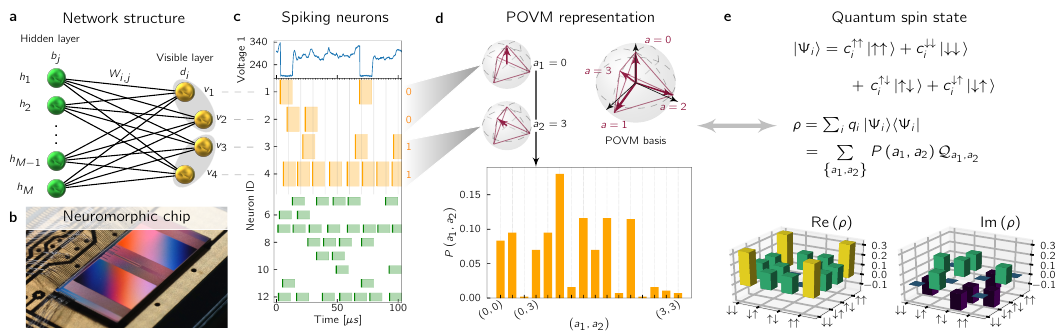
Figure 1: Neuromorphic representation of quantum states. a , Two-layer spiking network architecture with weight parameters W between the visible (orange) and i , j hidden (green) neurons and biases d ( b ) for the binary visible (hidden) neurons. i j b , Photograph of the BrainScaleS-2 chip used as a substrate for the experiments in this work. c , Dynamical evolution of the spiking network. Upper panel: membrane potential evolution of a single LIF neuron integrating synaptic input. Whenever the potential crosses a threshold a spike is generated and the potential is clamped to pre- vent immediate refiring (refractory period). Lower panels: Spikes (solid lines) for 4 visible (orange) and 8 hidden (green) neurons with associated z = 1 time frames (shaded regions). The network state is observed periodically (gray lines showing only every fifth observation time for visibility reasons). Each observation results in a binary vector corresponding to a sample drawn from the underlying distribution. d , The 4-state positive-operator-valued measure (POVM) representation of a qubit state can be encoded by a pair of visible neurons. A combination of N such neuron pairs thus serves to represent an N -qubit system. The frequency of occurrence of neuron configurations drawn from a trained network encodes the POVM probability distri- bution of a quantum state (lower panel). e , Any quantum state can be represented 〉 . For the exam- as a density matrix ρ , which can be a statistical mixture of states | Ψ i ple of two qubits shown here, the complex-valued entries of ρ can be reconstructed ) . For the definition of the operators linearly from the sampled probabilities P ( a , a 1 2 Q , see App. a 1 , a 2